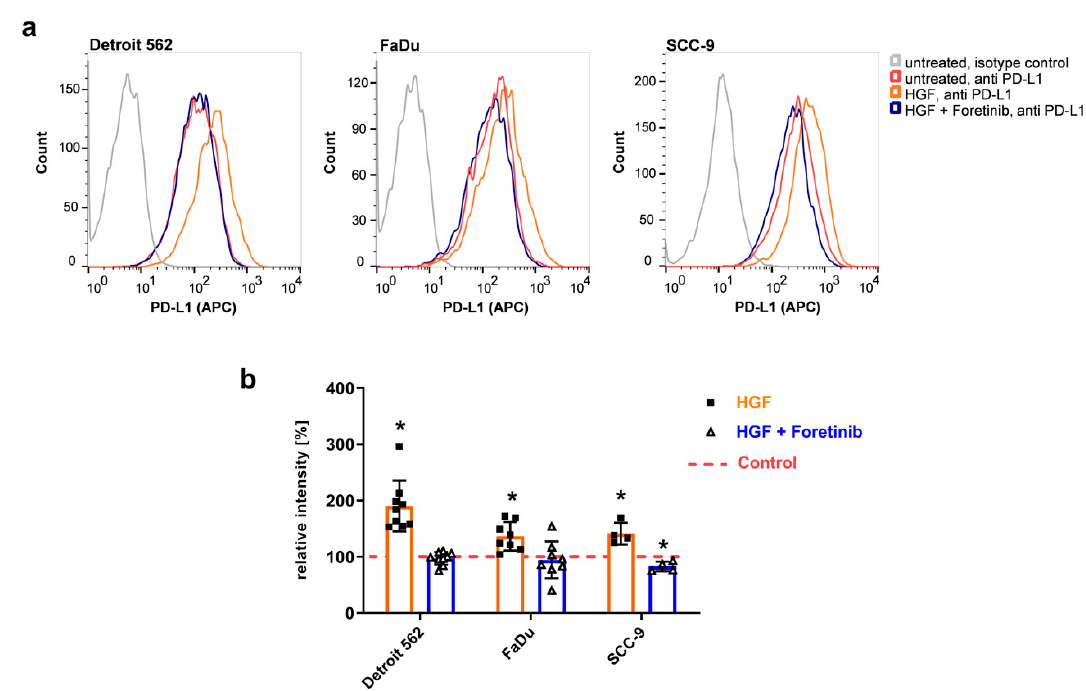
Figure 2. PD-L1 concentration on the cell surface is enhanced upon HGF treatment. Three HNSCC cell lines (Detroit 562, FaDu, and SCC-9) were treated with 50 ng / mL HGF (orange), HGF and 0.5 µ M foretinib (blue) or remained untreated (red). After 48 h, cells were stained for flow cytometry using an APC-coupled antibody specific for PD-L1 or an isotype control (exemplarily shown for untreated control in grey). Histograms for one experiment out of at least four are shown in ( a ). A summary of all experiments shows fluorescence median values of all tested cell lines and conditions (corresponding isotype controls subtracted) relative to the untreated control, which is indicated by the dashed red line ( b ). *: p -value ≤ 0.05 in a one-sample t -test.